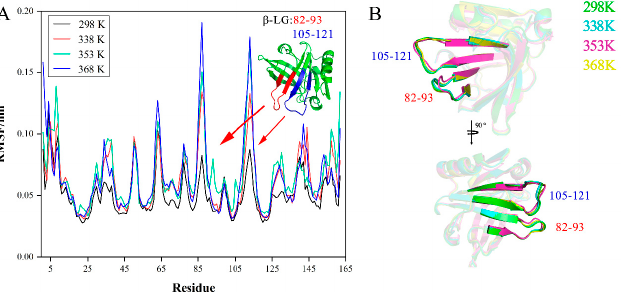
Figure 8. MD simulates the stability of allergic epitopes of β -LG in different temperature environments: ( A ) RMSF plot of protein, and ( B ) conformational differences in regions 82–93 and 105–121 in different environments. The arrow indicates the amino acid sequence and protein structure of this position.